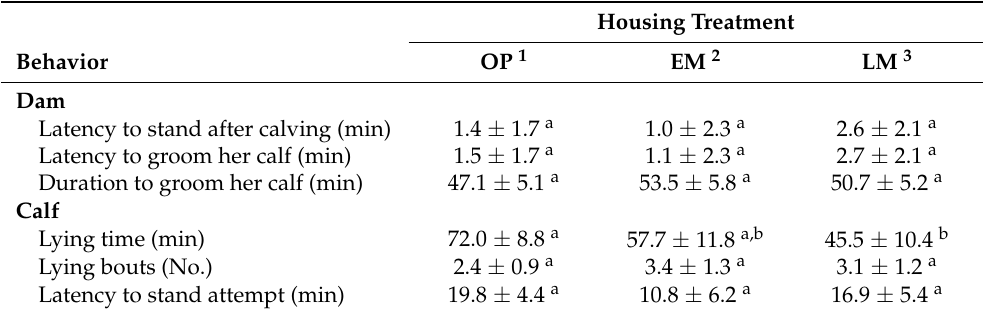
Table 2. Effect of housing treatment on dam and calf behaviors during the first 1.5 h after calving (LSM ± SE).